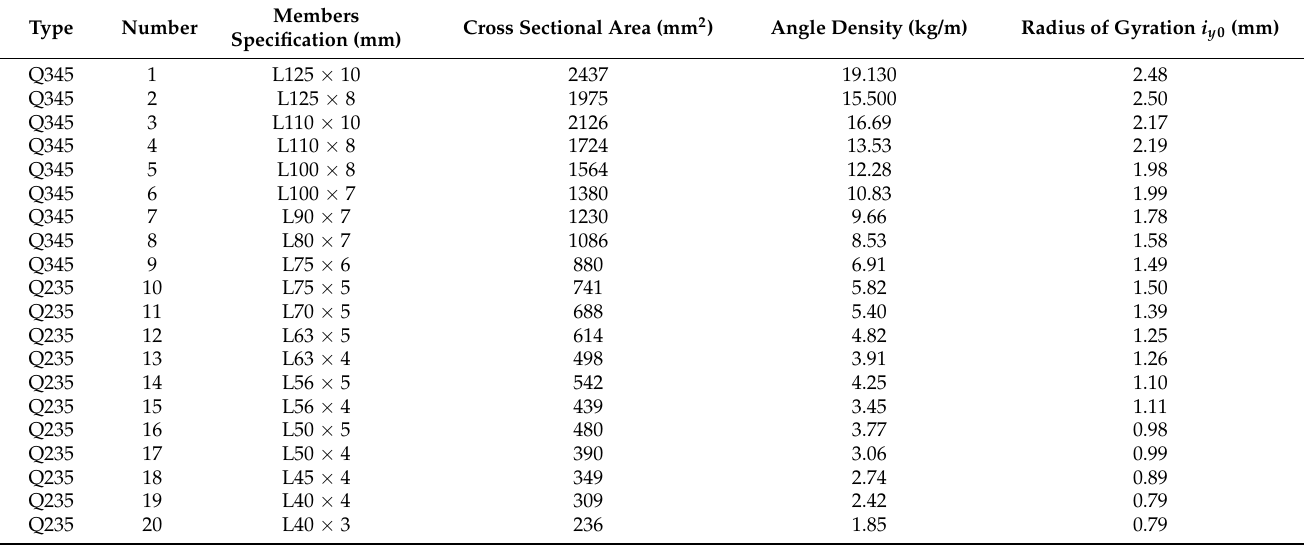
Table 2. Information of angles in model tower.